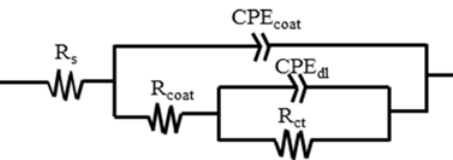
Figure 9. Equivalent circuit model for samples: R s ( Q coat ( R coat ( Q dl R ct ))).